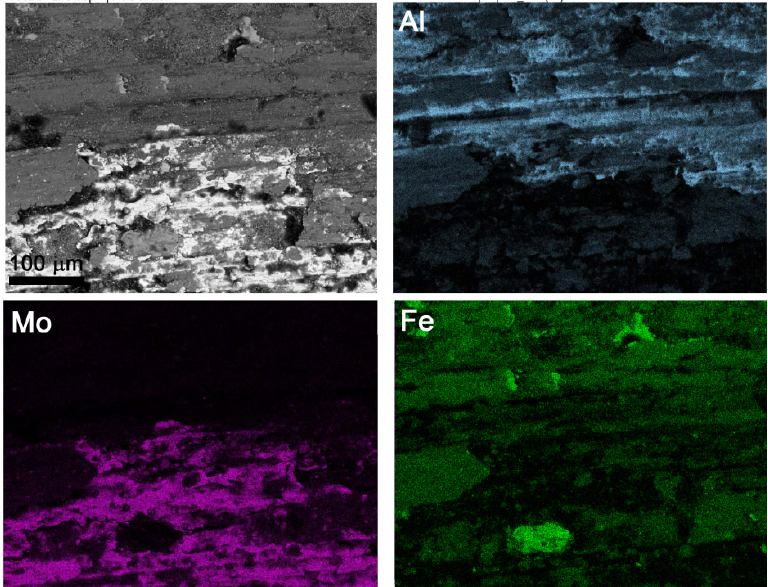
Figure 16. Mo-rich areas on the worn surface of 0.9 g/layer sample.